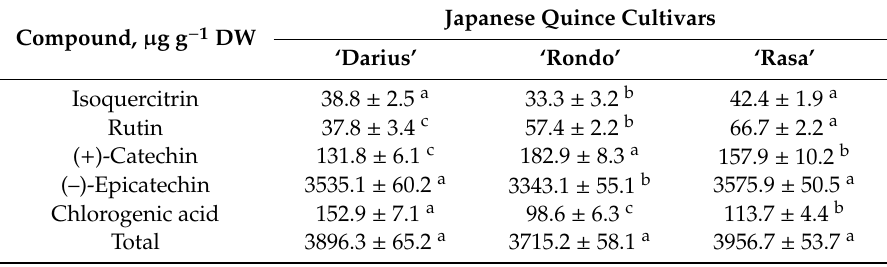
Table 5. The quantitative composition of phenolic compounds in quince fruit, µ g / g